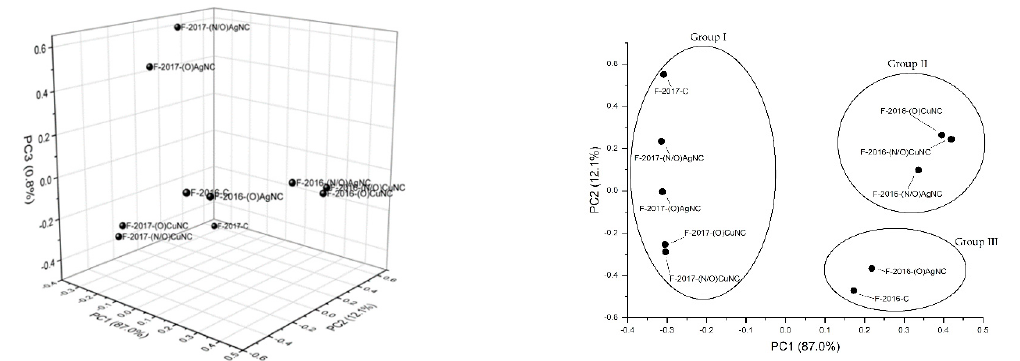
Figure 5. ( left ) Scattered scores plot (PC1 × PC2 × PC3) based on the FTIR spectral fingerprint of oil samples; and ( right ) scattered scores plot (PC1 × PC2) based on the FTIR spectral fingerprint of oil samples.